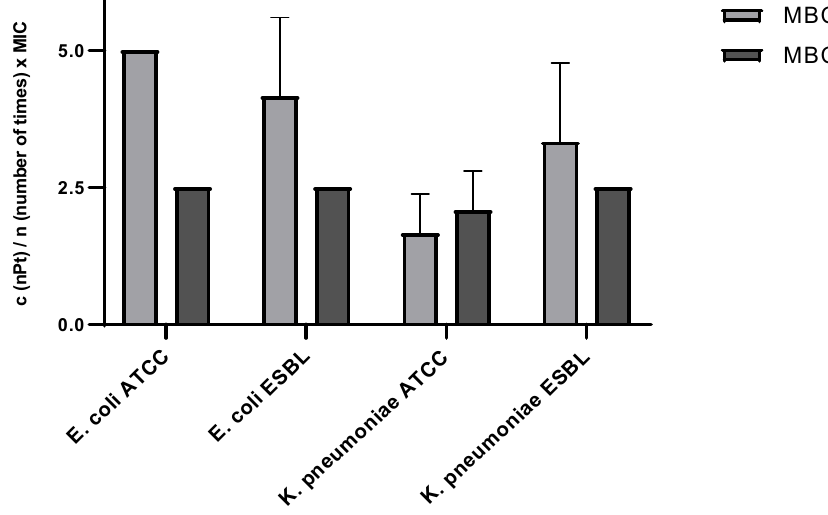
Figure 4. Comparison of bacterial planktonic cell survivability after 48 and 72 h of platinum nanoparticle exposure. Values are expressed as means ± standard deviations. c—concentration.